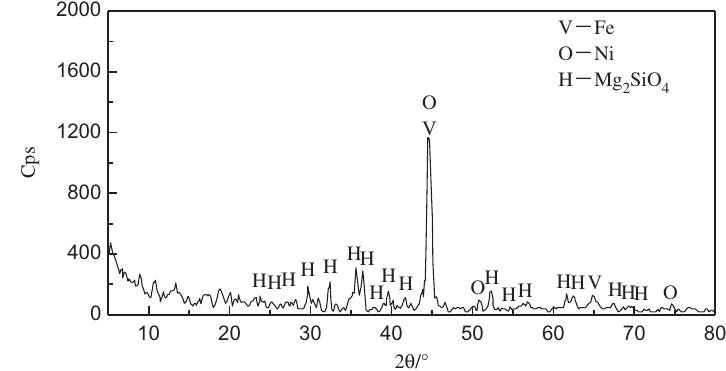
Figure 1: X-ray diffractogram of pre-concentrate